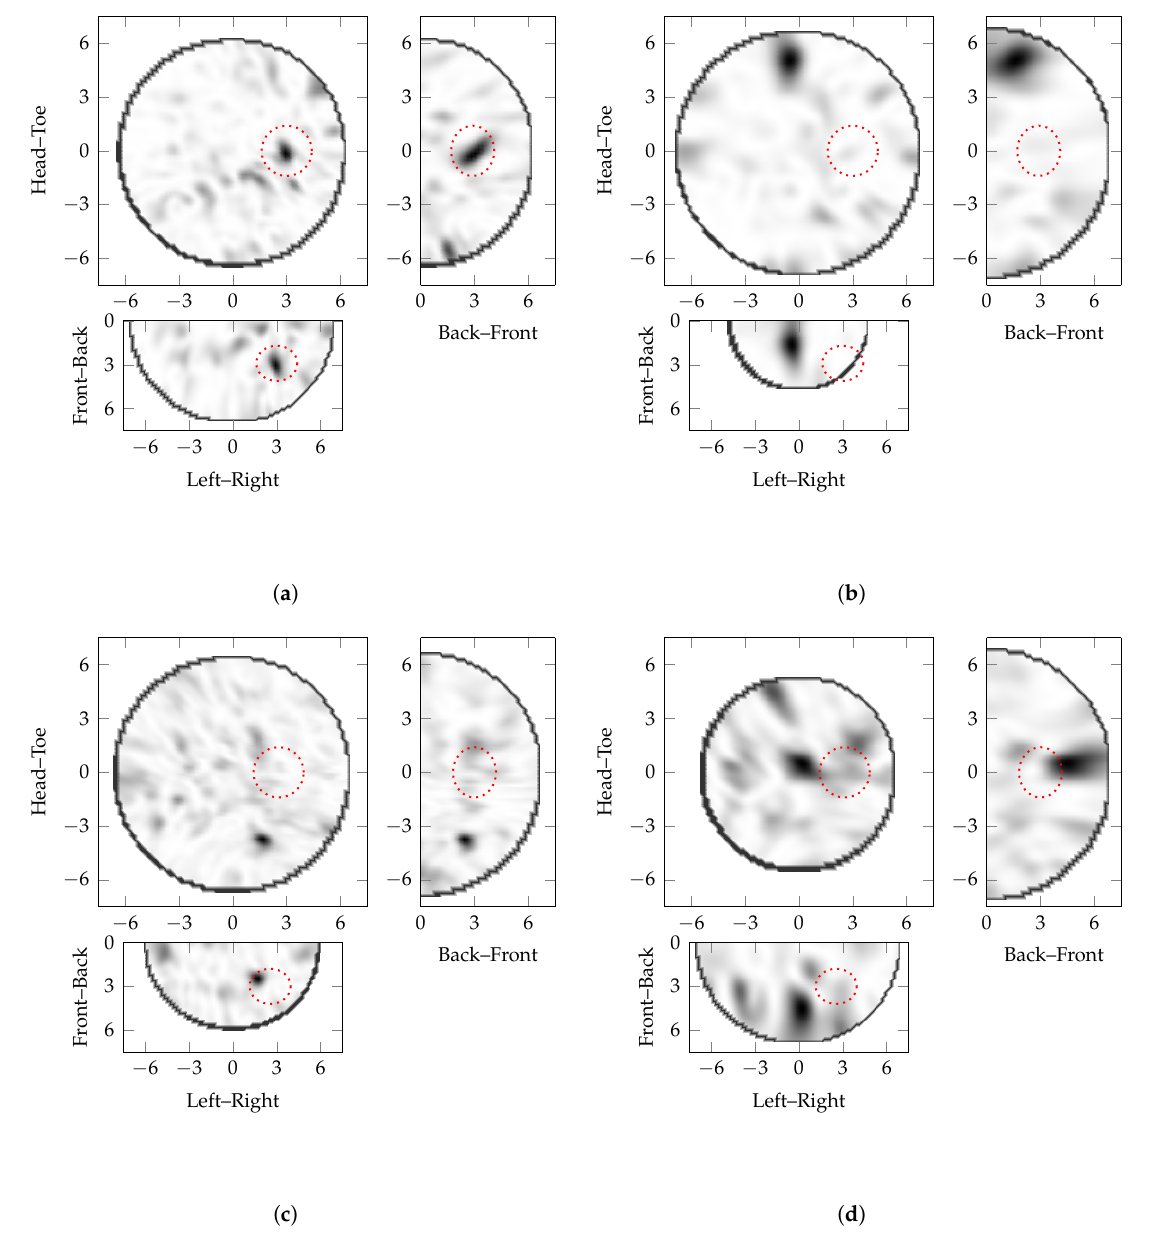
Figure 5. Shown are coronal, sagittal and transverse slices of images of the tumour model T 4 . ( a , b ) are in a phantom with 10% glandular structures by volume and ( c , d ) are in a phantom with 30% glandular structures by volume. ( a , c ) are the images selected by the Gaussian Energy, φ G ; and ( b , d ) are the GSS images selected by the Modified Laplacian, φ L . The actual target location is marked by the dotted, M red ellipse in each